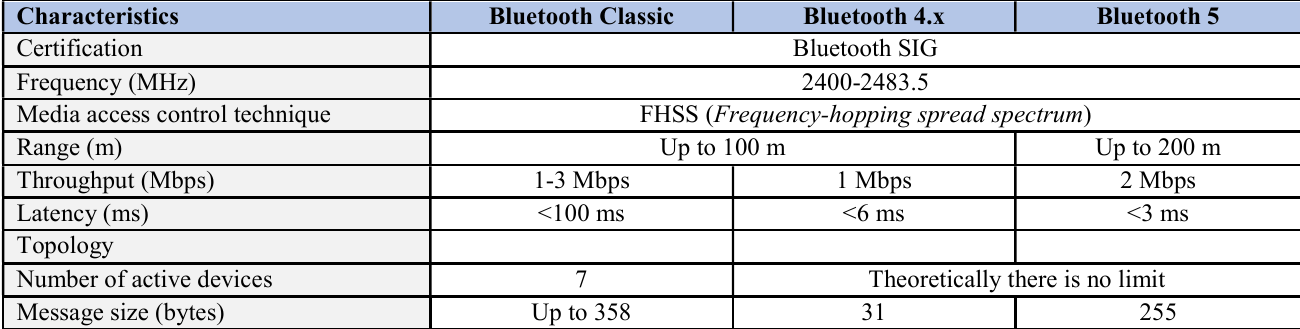
Table 5. Basic characteristics of Bluetooth